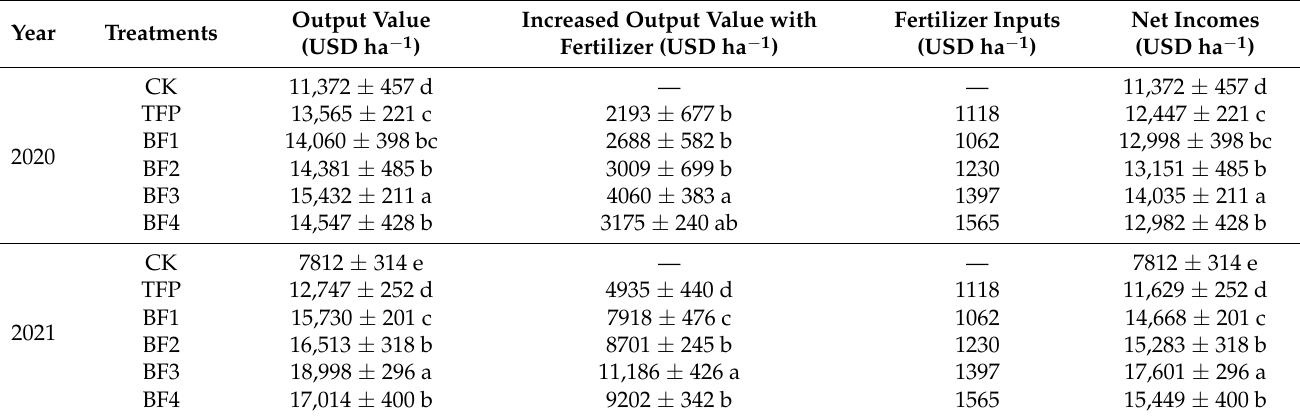
Table 4. Effects of BF on economic benefits of eggplant in 2020 and